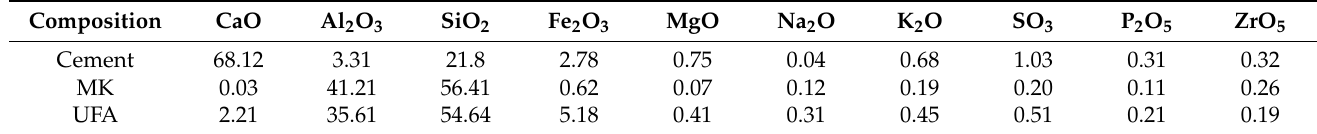
The mixture proportion of admixture concrete is shown in Table 1. Table 1. Chemical composition of cementitious